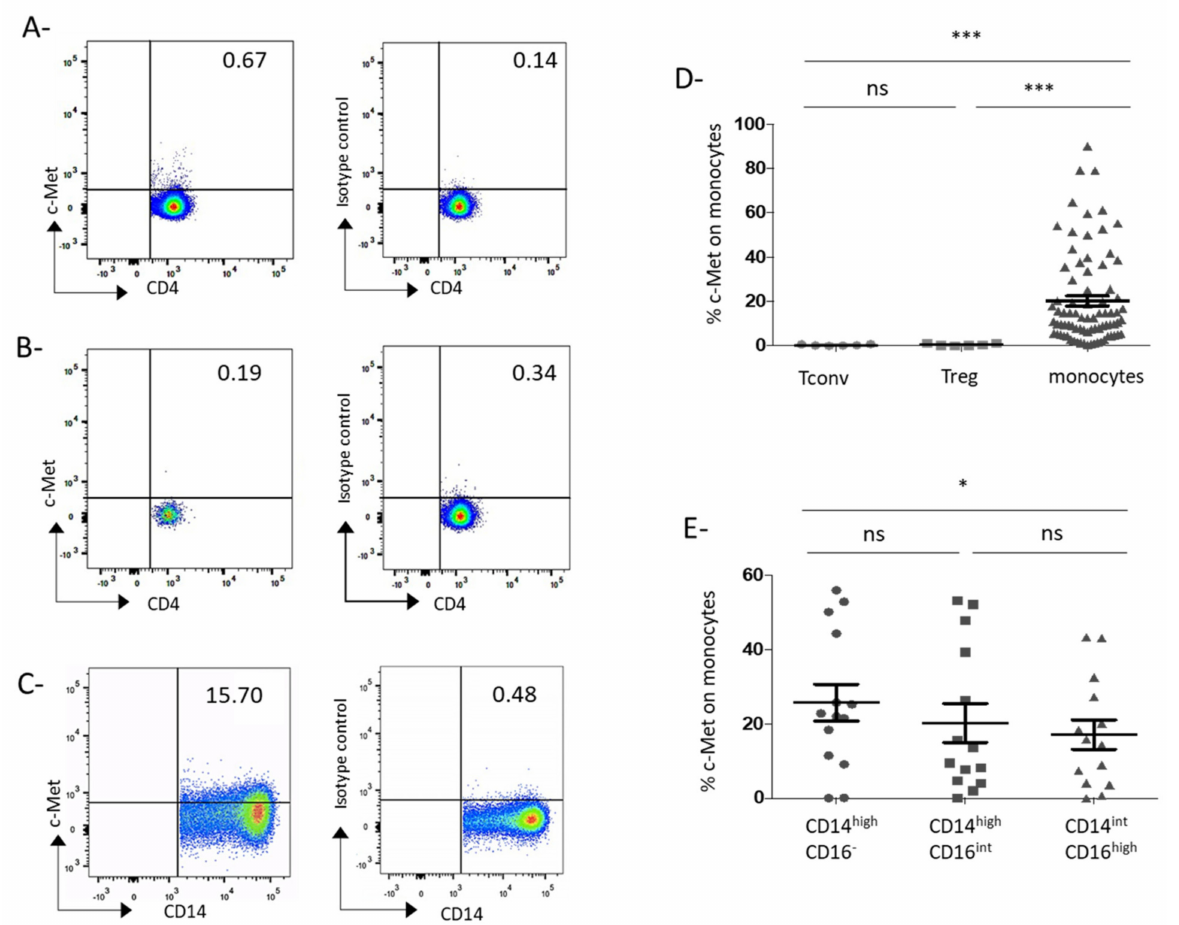
Figure 1. Circulating monocytes but not circulating conventional or regulatory T cells express the c-Met receptor in GC patients. Freshly isolated PBMCs from GC patients were stained with fluorochrome-conjugated antibodies or their isotype control and analyzed by flow cytometry. Tconv were defined as CD4 + /CD25 − cells. Treg were defined as CD4 + /CD25 + /Foxp3 + /CD127 low cells. Monocytes were defined as CD14 + /HLA-DR + /CD3 − /CD56 − /CD19 − cells. ( A – C ) Representative c-Met expression by Tconv ( A ), Treg ( B ), and monocytes ( C ) of GC patients. Results are indicated in percentages of c-Met positive cells. ( D ) Mean c-Met expression by peripheral Tconv (mean ± SEM: 0.36 ± 0.13%; n = 6), Treg (mean ± SEM: 0.55 ± 0.20%; n = 6) and monocytes (mean ± SEM: 20.24 ± 2.32%; n = 80) from GC patients. *** indicates a p -value ≤ 0.001 according the Kruskall-Wallis multiple comparisons test. ( E ) Mean c-Met expression by the three monocytes subpopulations from GC patients ( n = 14): CD14 high /CD16 − (mean ± SEM: 25.67 ± 4.95%), CD14 high CD16 int (mean ± SEM: 20.24 ± 5.26%) and CD14 int CD16 high (mean ± SD: 17.10 ± 3.914%). * indicates a p -value ≤ 0.05 according the Friedman multiple comparisons test. Ns: